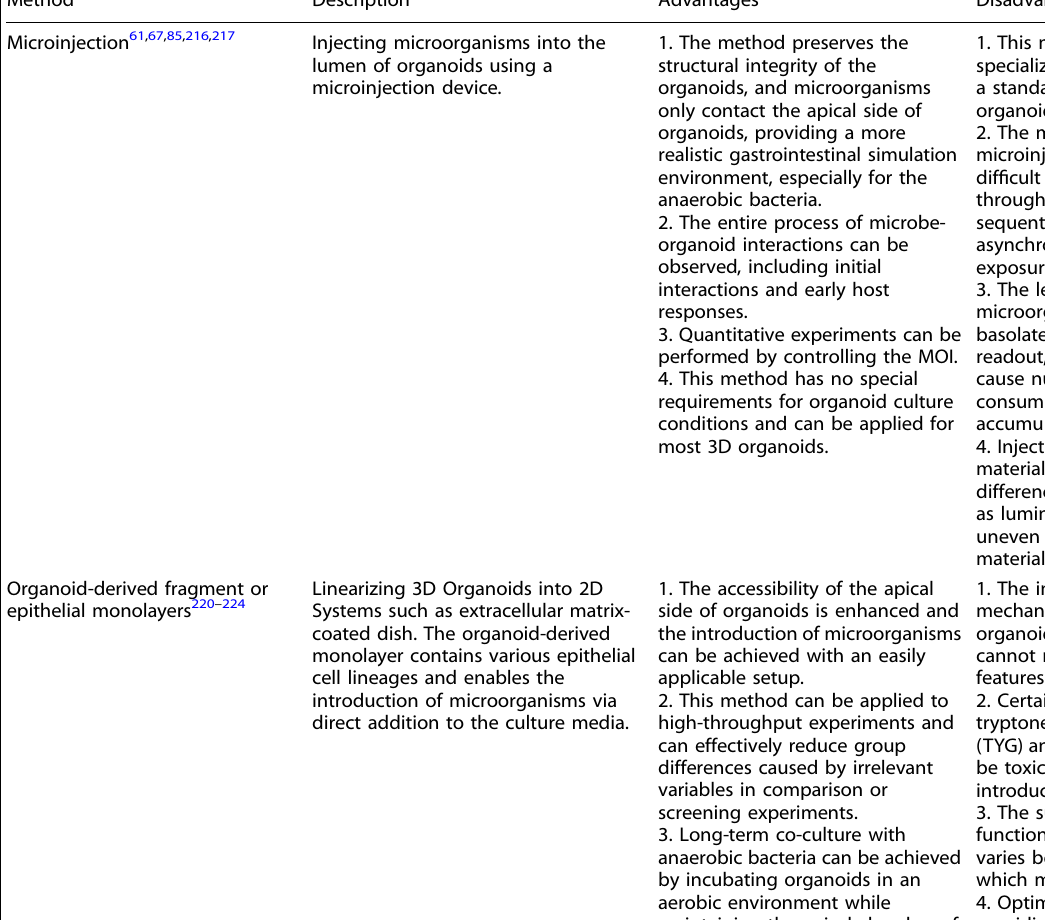
Table 1. Comparison of methods for introducing microorganisms into organoids